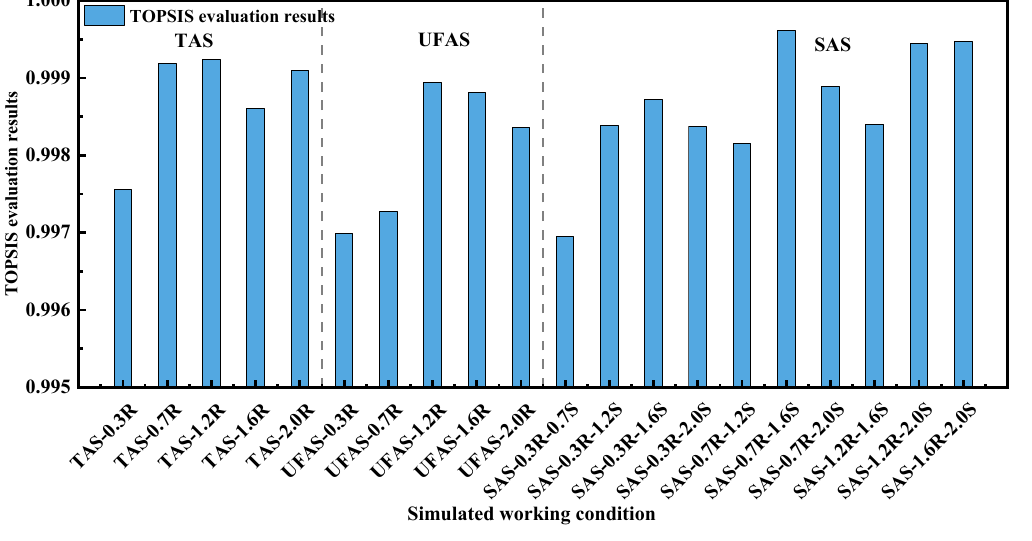
Figure 11. TOPSIS evaluation results.